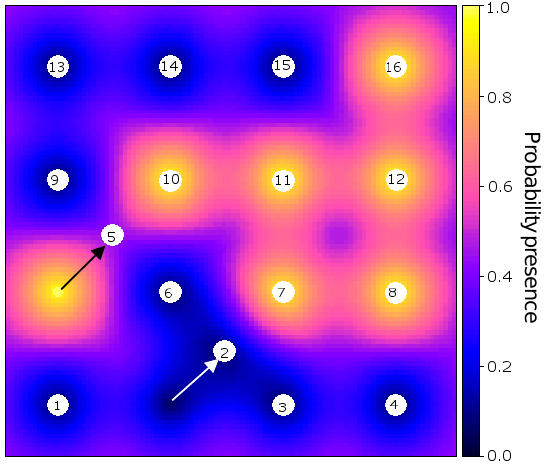
Figure 3. Configuration of initially regularly spaced sensors after two iterations with a single observation per step (scenario 1). First sensor 2 moved (white arrow) and a measurement was made, next sensor 5 moved (black arrow) but the measurement has not yet been